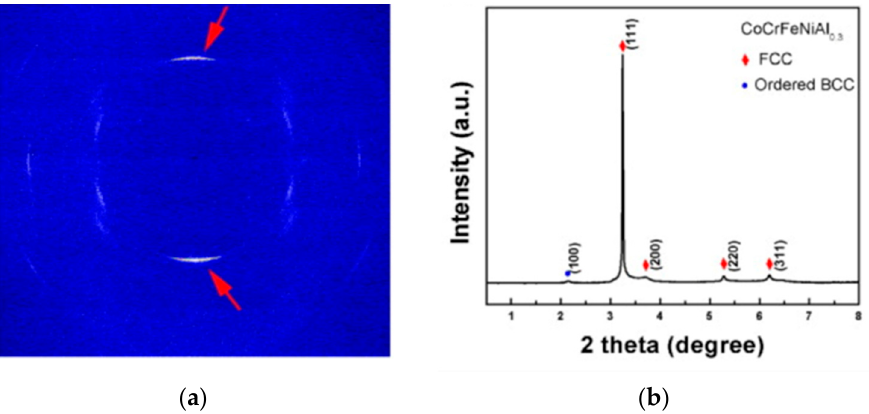
Figure 3. AFM images of Al 0.3 CoCrFeNi with different deposition times of ( a ) Synchrotron XRD of Al 0.3 CoCrFeNi and ( b ) XRD diffractogram of FCC structure for Al 0.3 CoCrFeNi. Reprinted with permission from Ref. [33] Copyright 2017 Elsevier.